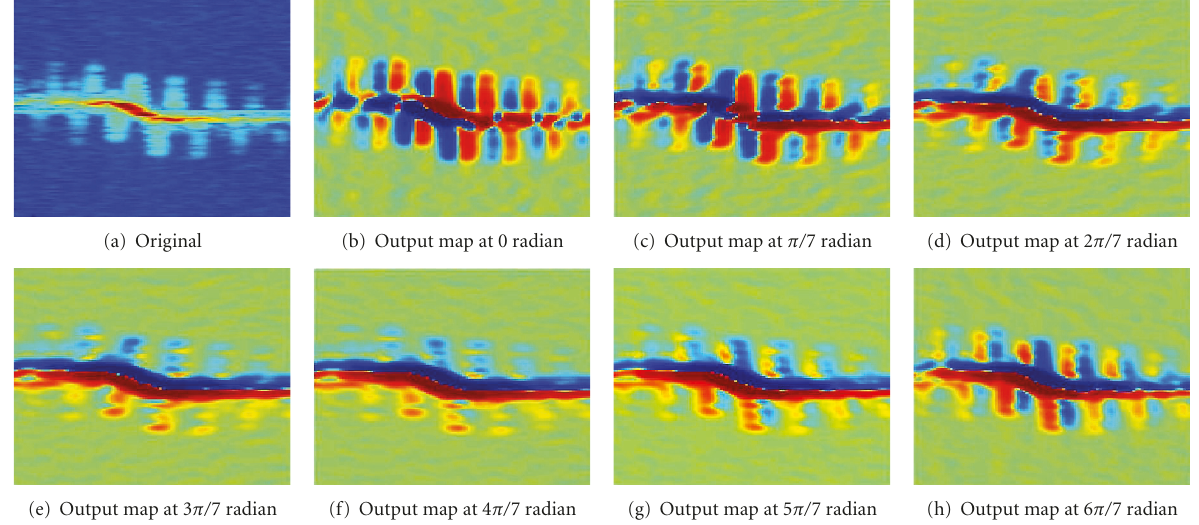
Figure 10: Outputs of Stage 1 filters for one-arm spectrogram input.